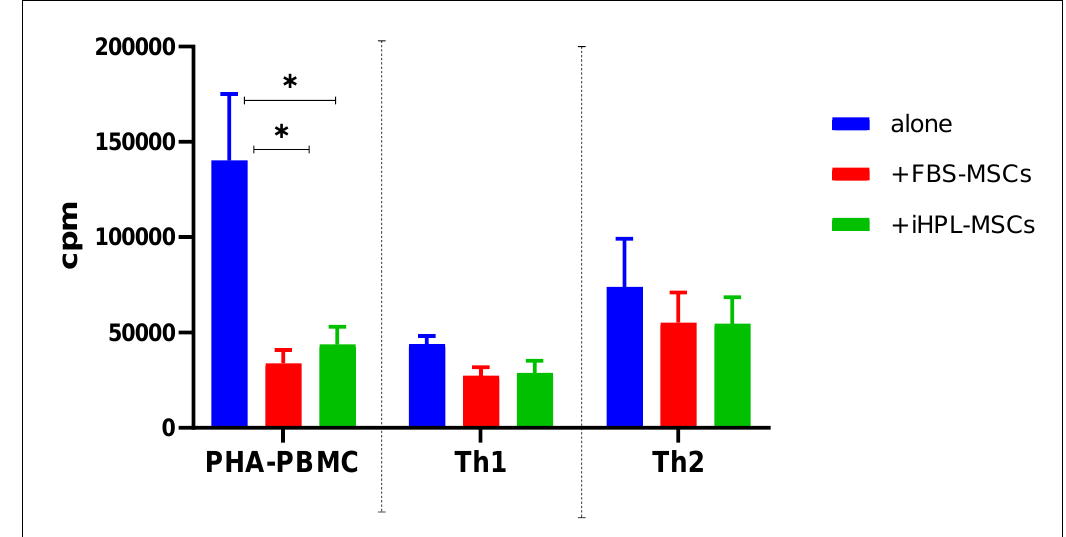
Figure 2. Proliferative assay on stimulated peripheral blood mononuclear cells (PBMCs) and on induced Th1 and Th2 cells alone, and in co-culture with FBS-MSCs or iHPL-MSCs. Each histogram represents the mean values ± standard error mean (SEM) of each condition ( n = 5), and the symbol * indicates statistically significant differences with p < 0.05.